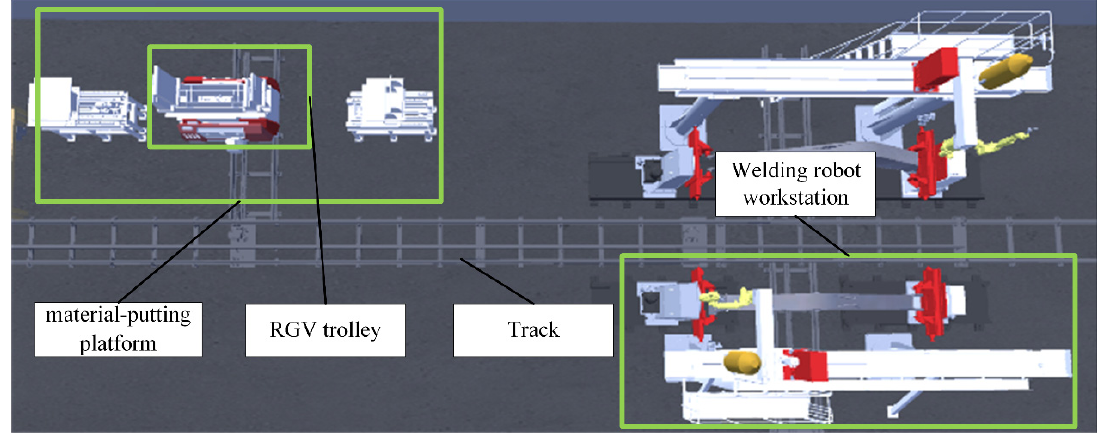
Figure 2. Schematic diagram of the cell structure of the welding robot workstation.